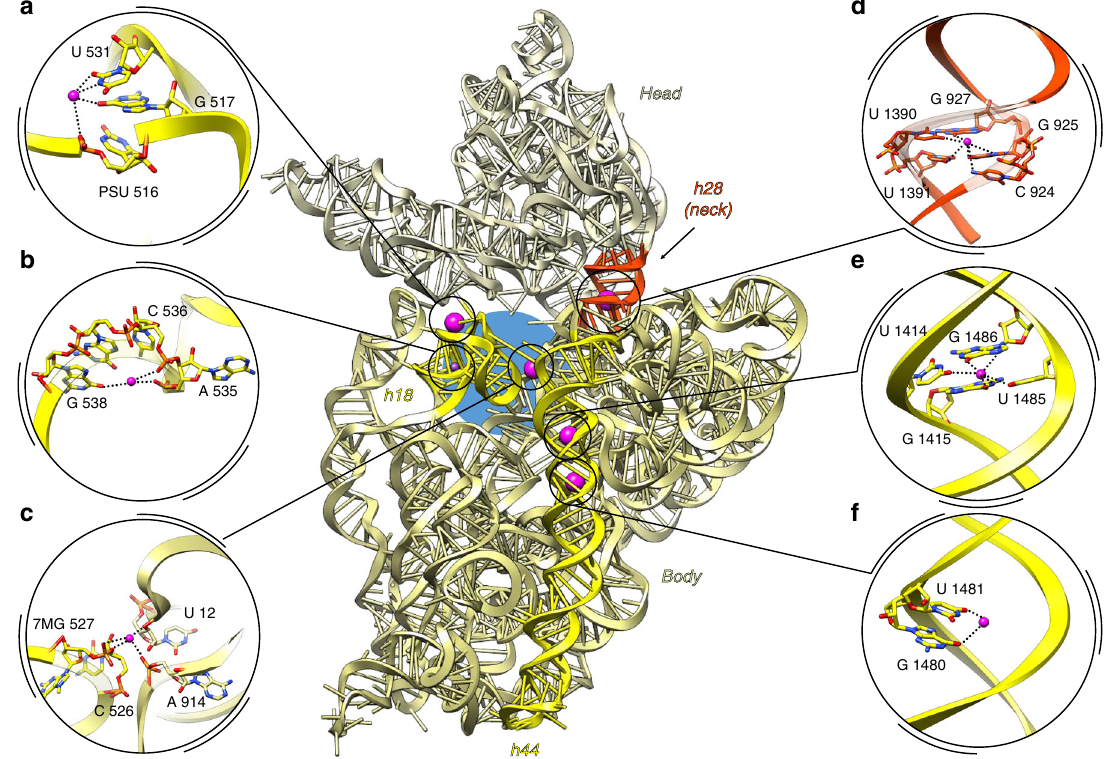
Fig. 5 Potassium ions support essential structural elements of 30S subunit. a – c decoding center forming helix 18, d neck, e , f helix h44. 16S rRNA is presented in ribbon (center). The head is colored in khaki, body in light olive green. At the interface portion of 16S rRNA, h44 and h18 are highlighted in yellow, neck between the head and the body colored in orange-red. Decoding center is marked with a blue circle. One of the potassium ions coordinated in h18 ( b ) was found only in one ribosome of the asymmetric unit of initiation complex and it is colored in violet and represented as small sphere in the overview